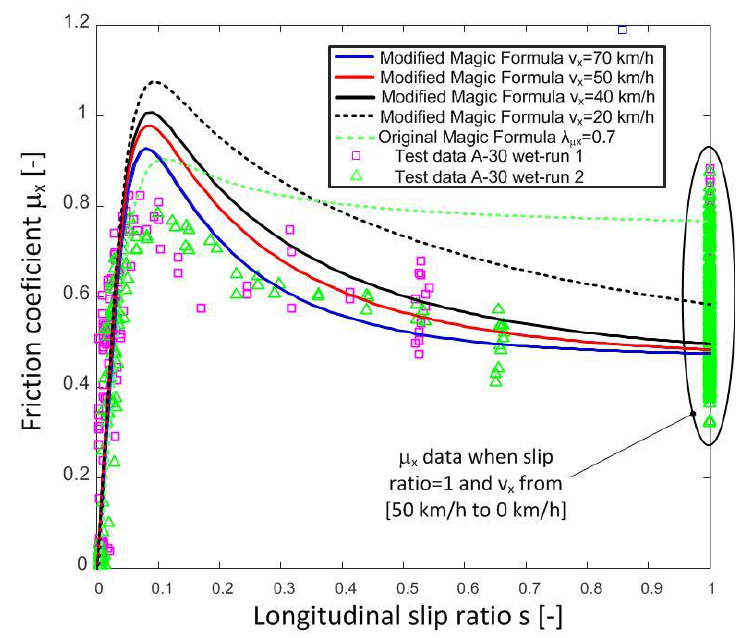
Figure 5. Longitudinal friction coefficient versus slip with different speeds. Highway A-30. Modified model of the Magic Formula.